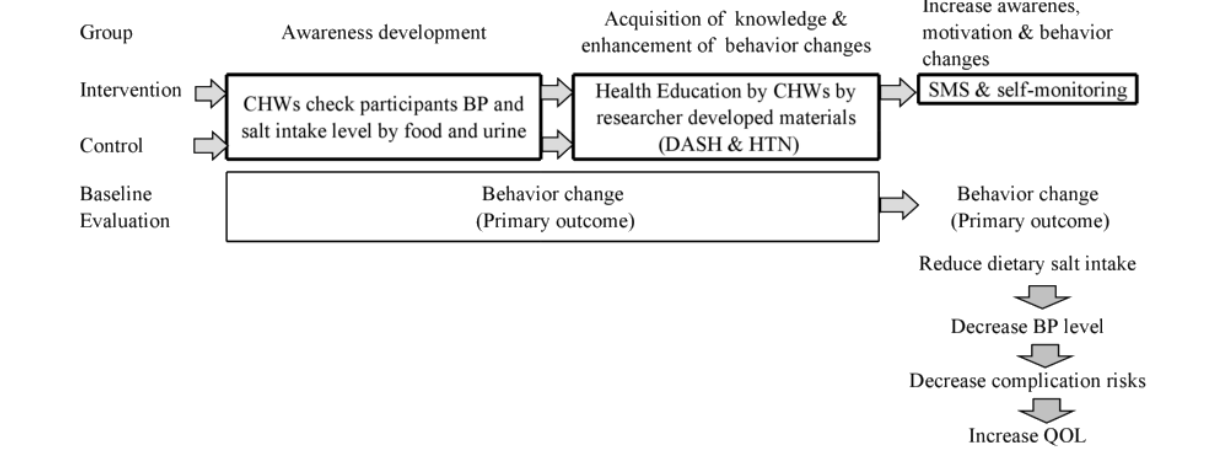
Figure 1. Awareness development process and contents of study